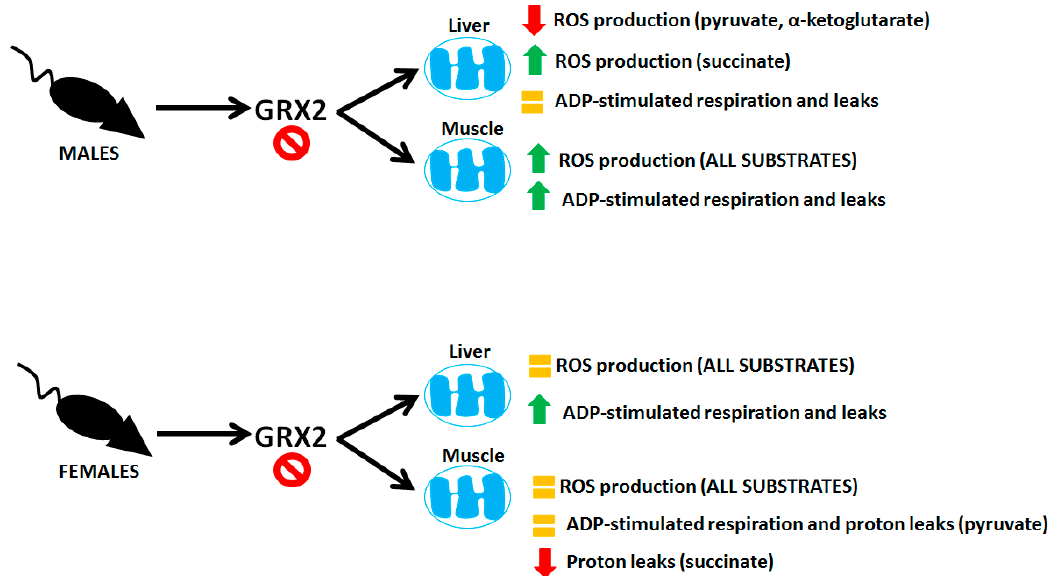
Figure 7. Sex-dependent differences in the bioenergetics of liver and muscle mitochondria isolated from mice containing a deletion for the Grx2 gene.